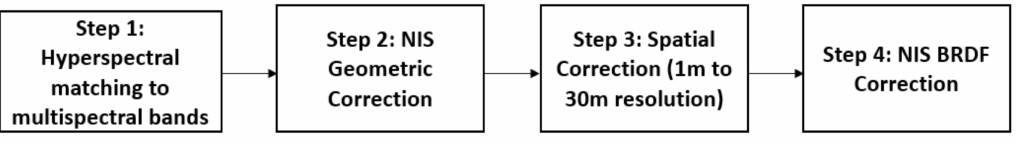
Figure 10. Flowchart of NIS SR correction